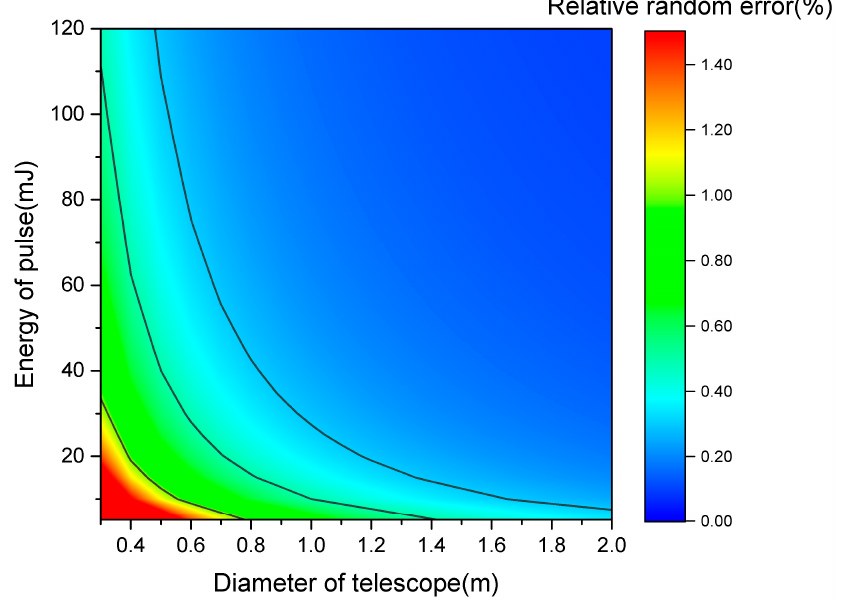
Figure 6. The effect of hardware parameters on the relative random error.